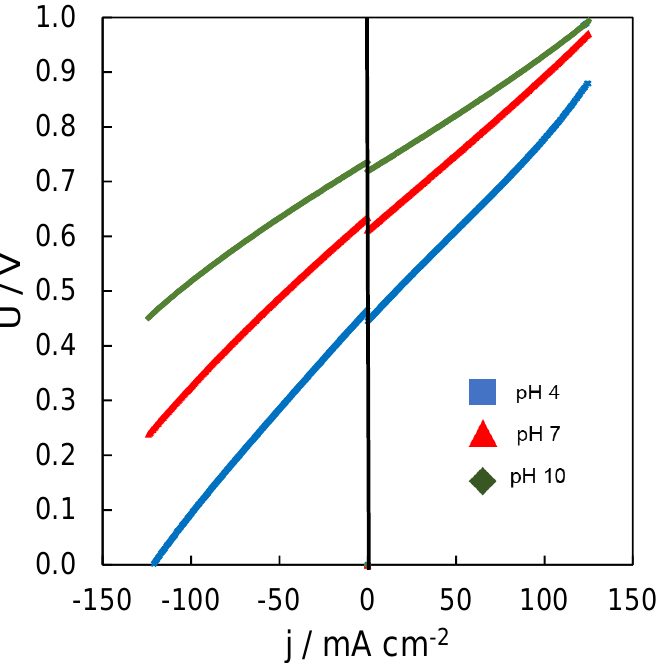
Figure 3. Load curves measured at 50% SOC at different pH values. A total of 0.08 M AQDS in 1 M buffer solution vs. 0.2 M Na 4 [Fe(CN) 6 ] in 1 M buffer solution was used, using pretreated Nafion 212 ® membrane. Scan rate: 1 mA/cm 2 ·s. Table 1. Open cell voltage, resistance at different SOCs, ion conductivity of the different electrolytes, energy efficiencies and capacity decay at different pH values.